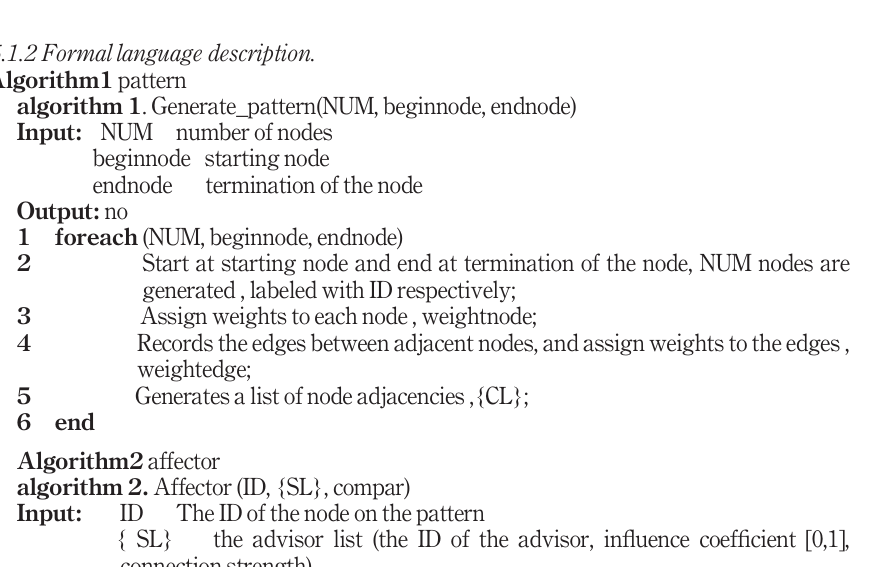
algorithm 2. Affector (ID, {SL}, compar)